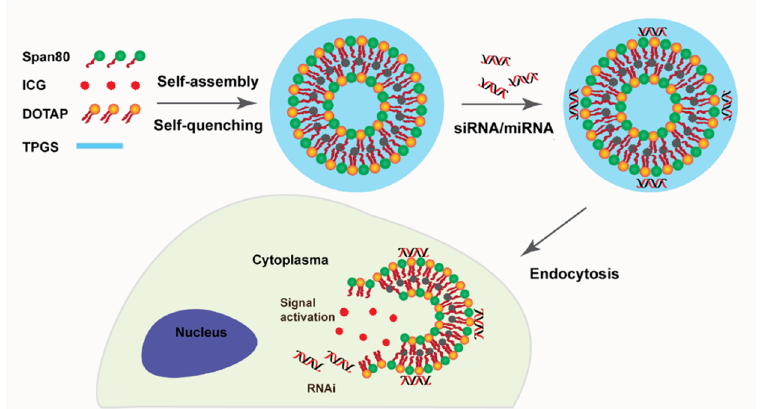
Figure 6. The design of theranostic niosomes for intracellular delivery of siRNA/miRNA and labelling of cells upon dequenching, reproduced with permission from [80], published by American Chemical Society,